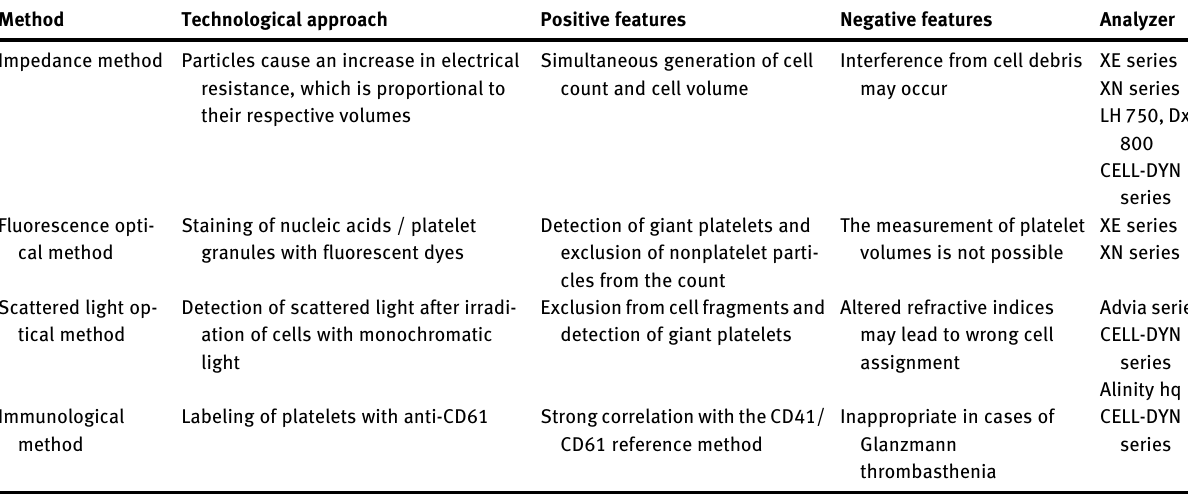
Table  : Different methods of automated platelet